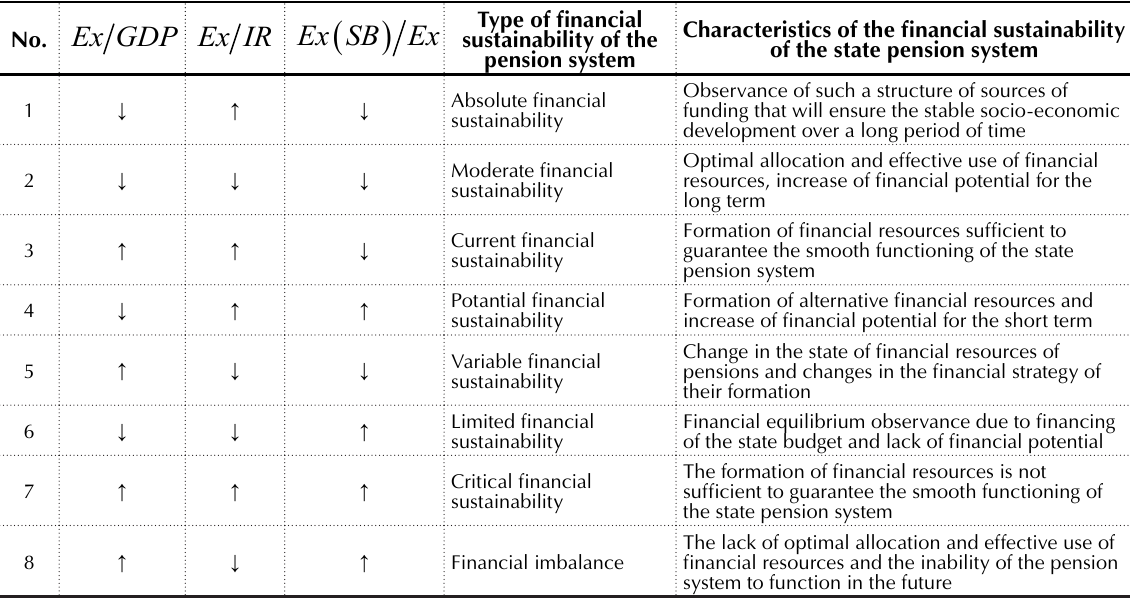
Table 5. Definition of the type of the Ukrainian pension system financial sustainability based on financial determinants